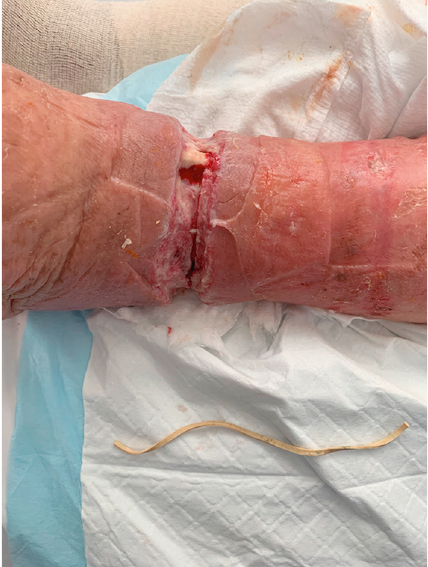
Figure 3: Circumferential leg wound after elastic band